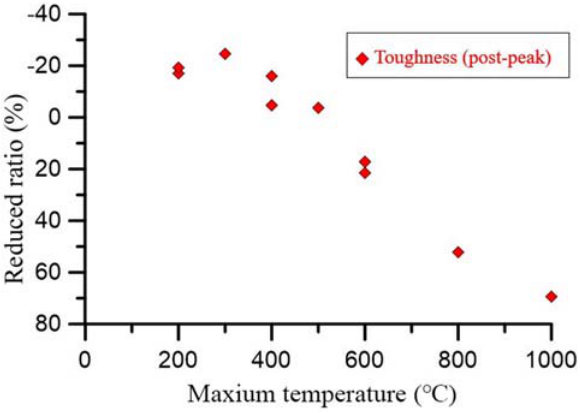
Figure 8. Maximum temperature effect on post ‐ peak toughness.